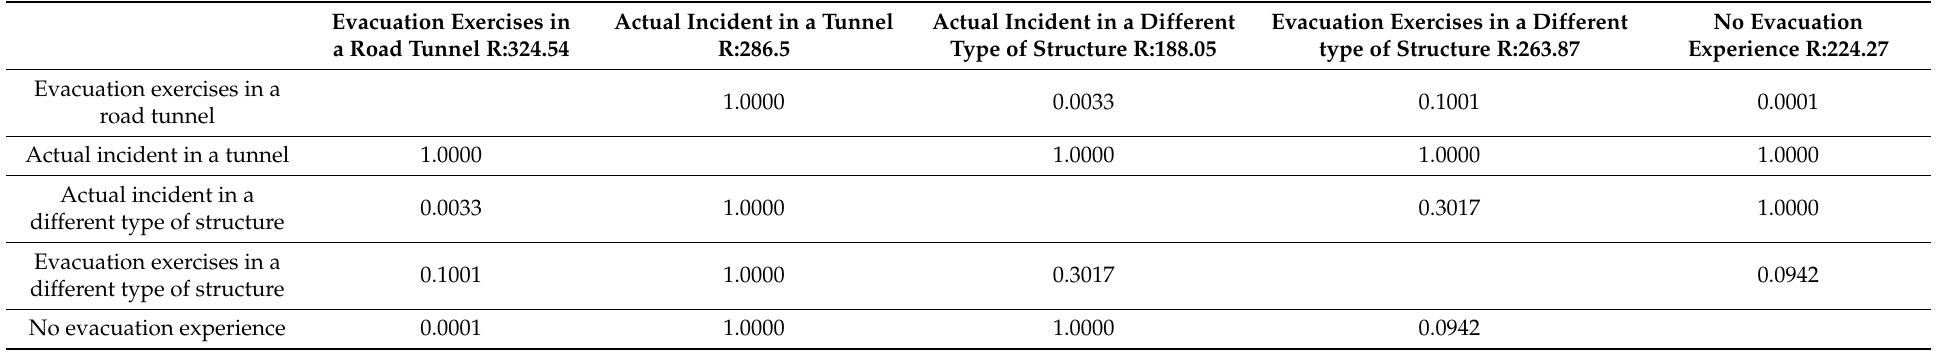
Table 3. Statistical differences on the level of knowledge of tunnel safety between the groups with different evacuation experience—the result of the Kruskal–Wallis test, H (5, N = 504) = 27.11625 p =